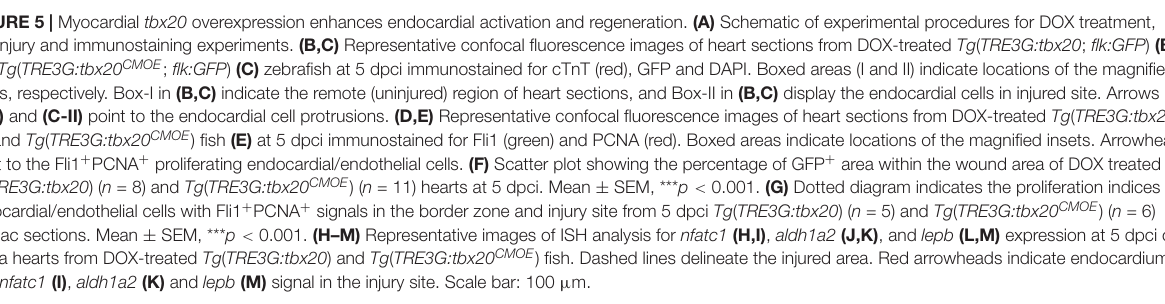
regeneration using zebrafish heart injury model ( Figure 7N